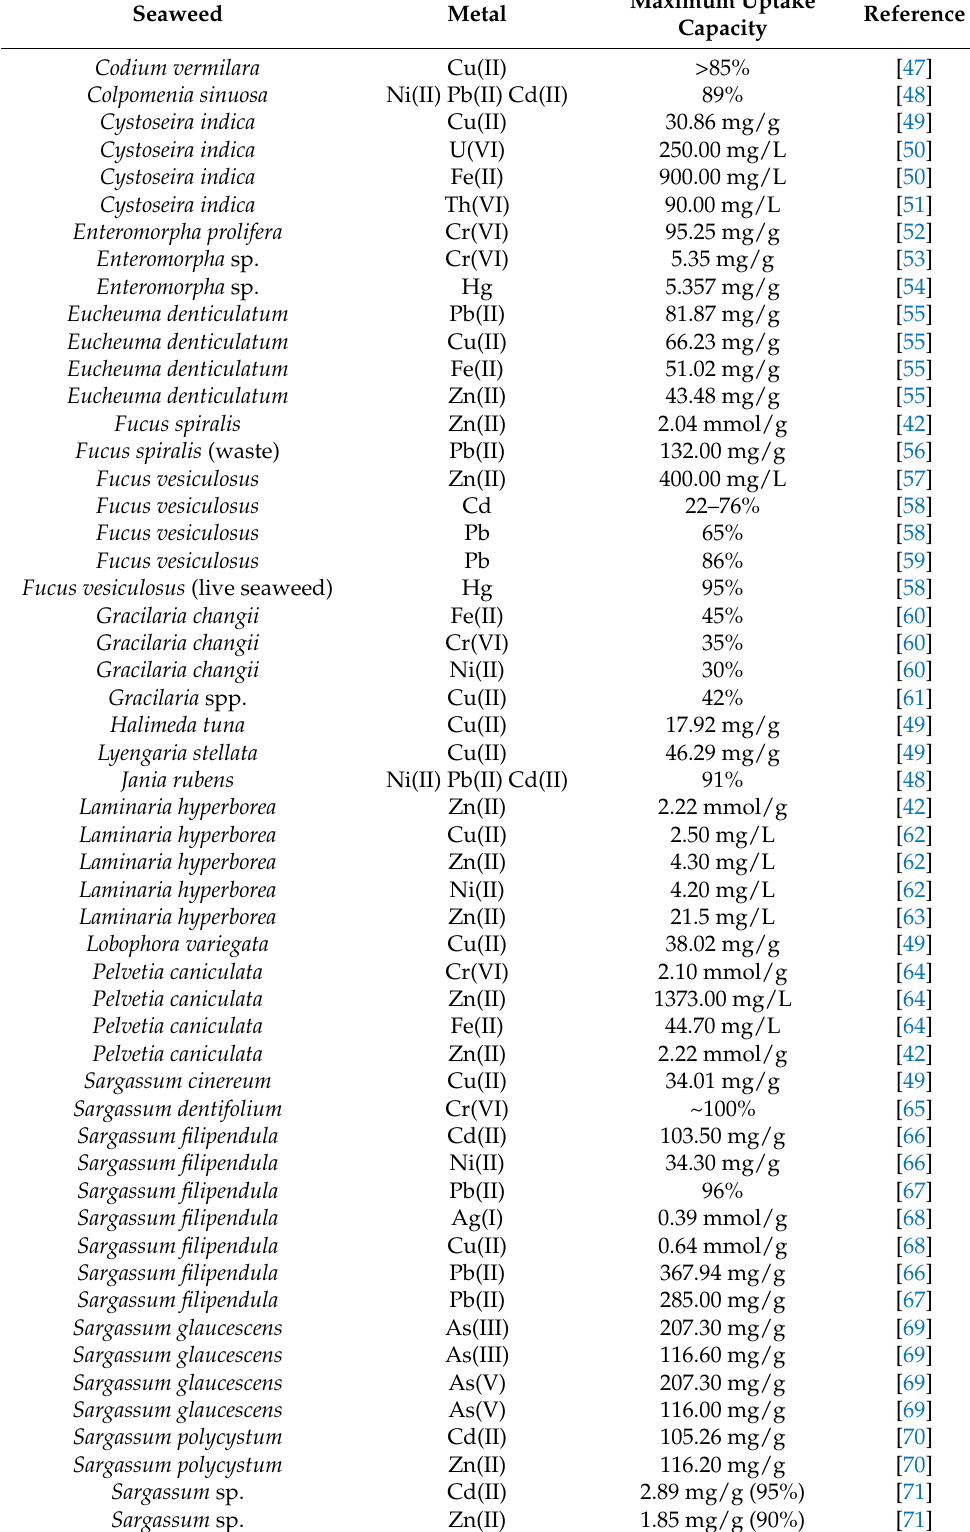
Table 3. Cont. Seaweed